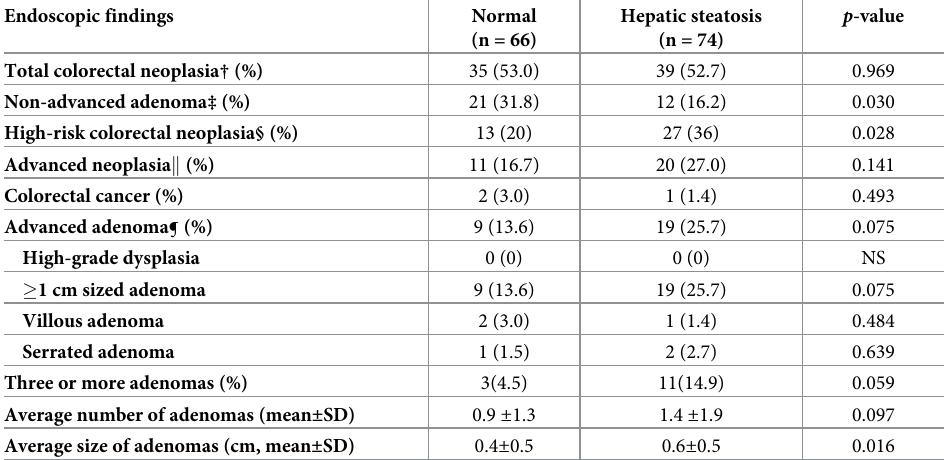
Table 3. Colonoscopy findings according to the presence of hepatic steatosis on